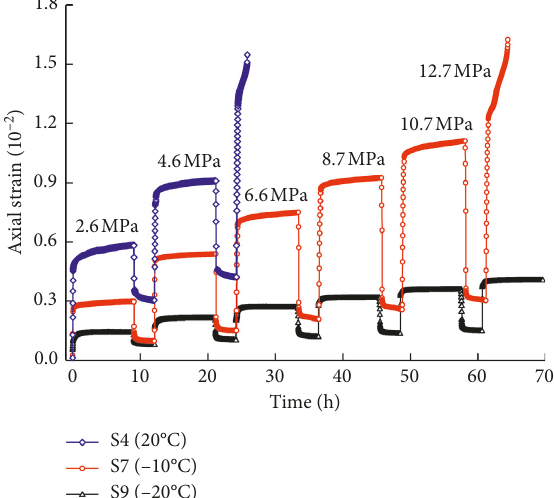
Figure 5: Uniaxial loading-unloading creep curves at different